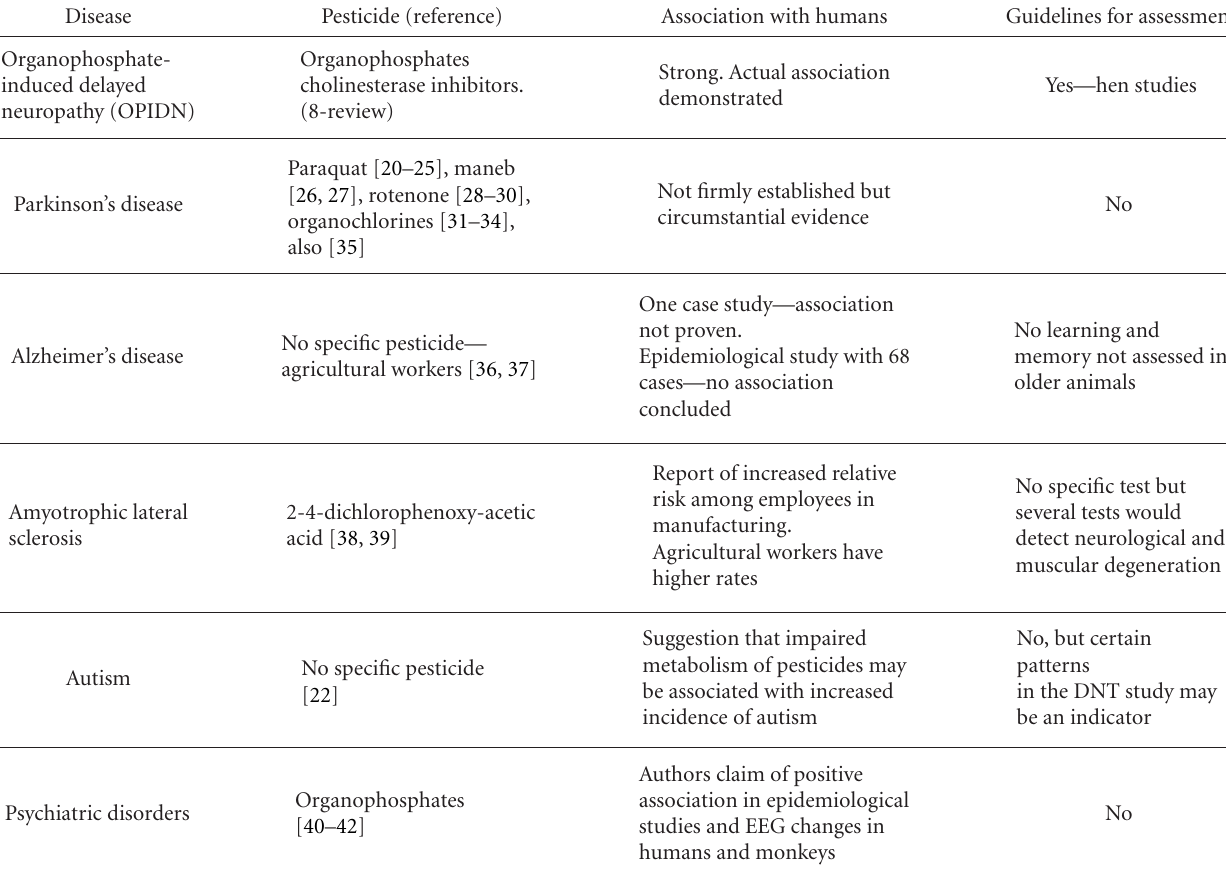
Table 1: Selected examples of human neurodegenerative and other neurological diseases both demonstrated and possibly attributed to